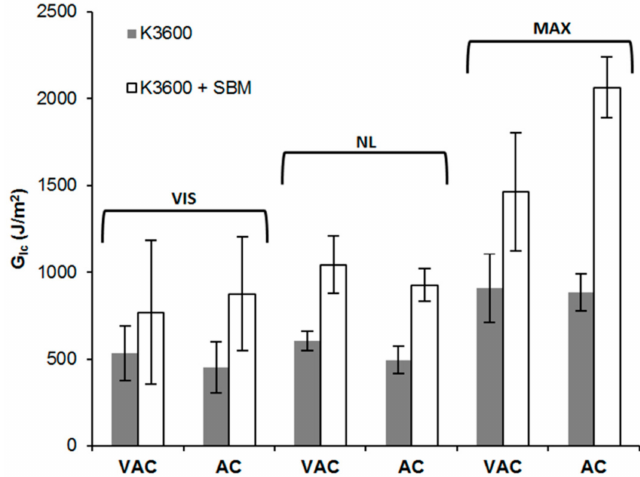
Figure 7. Visual (VIS), Non-linear (NL) and maximum (MAX) G Ic results for vacuum bag (VAC) and